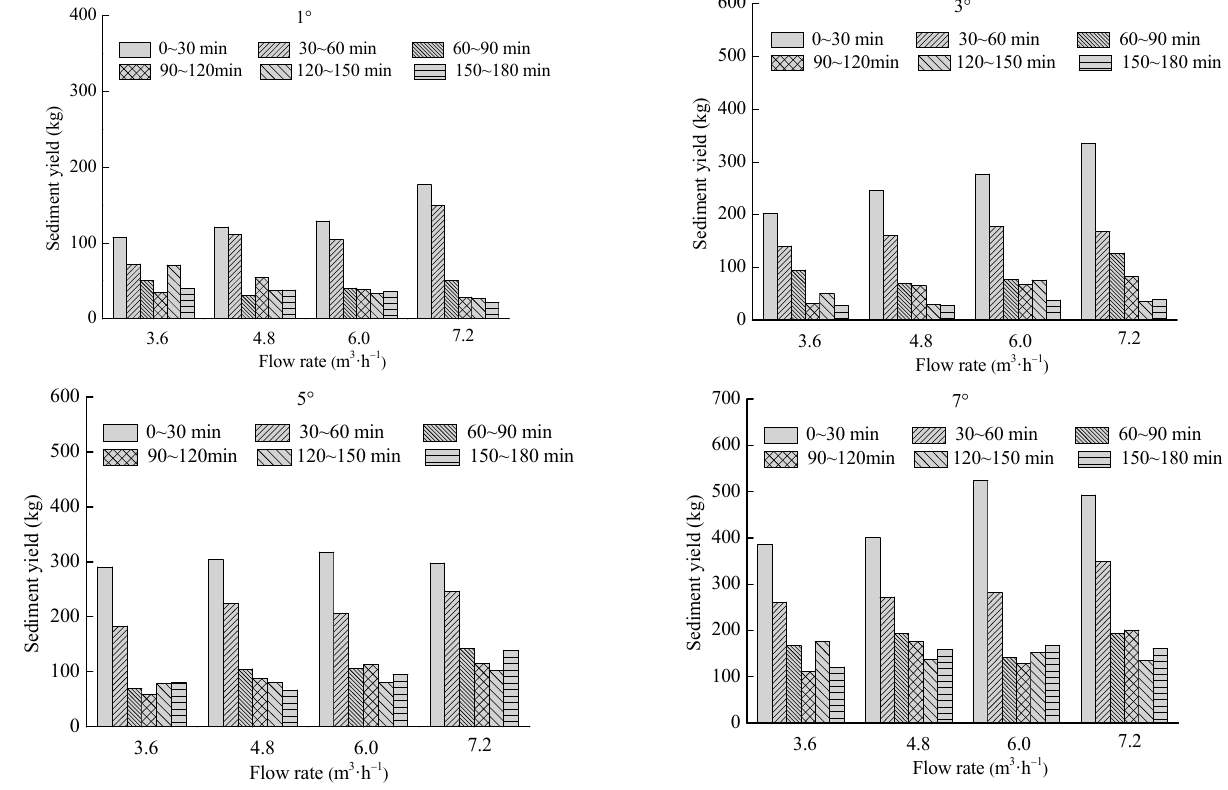
Figure 8. Sediment yield during different time